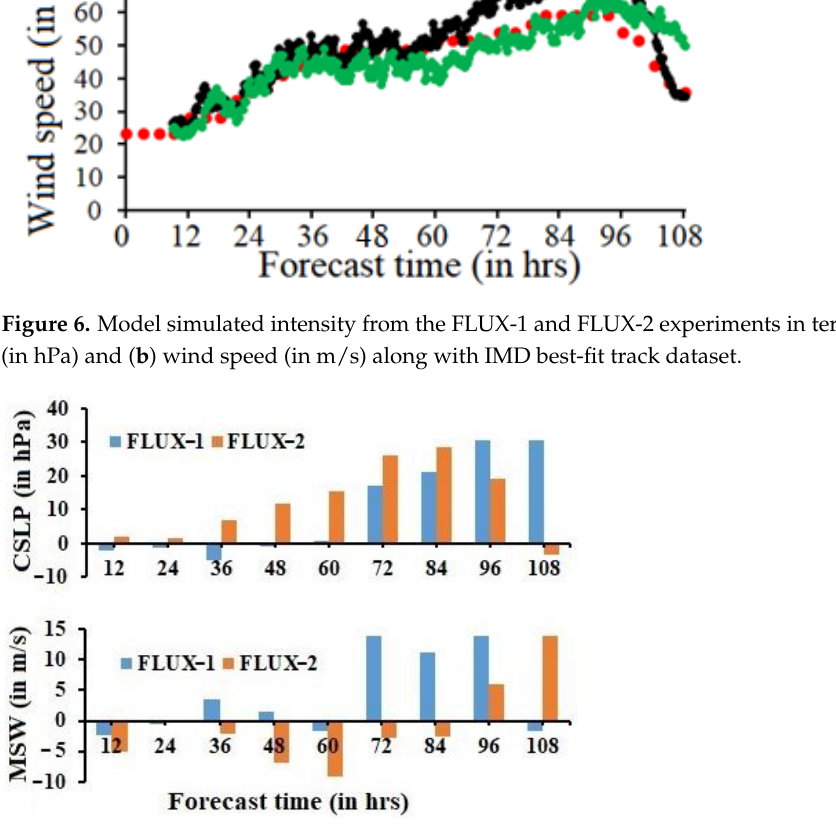
Figure 7 . Simulated intensity errors from the FLUX-1 and FLUX-2 experiments in terms of CSLP (in hPa) and MSW (in m/s). hPa) and MSW (in